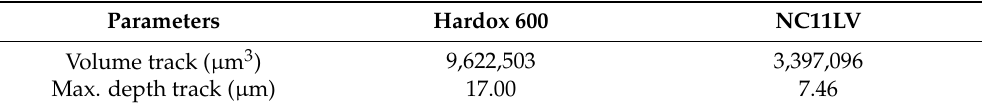
Table 2. Volume measurement results.